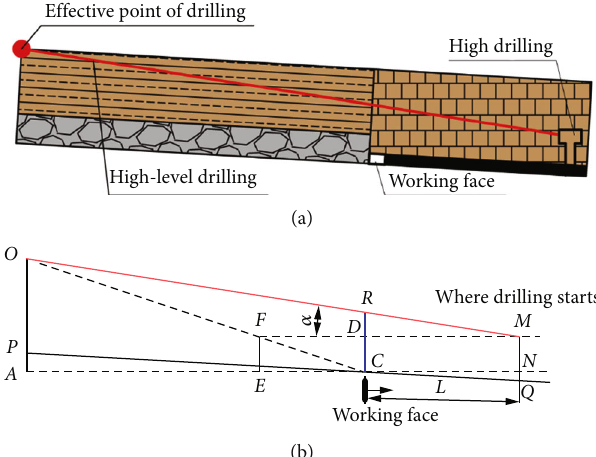
Figure 3: Schematic diagram of common high-level drilling in the